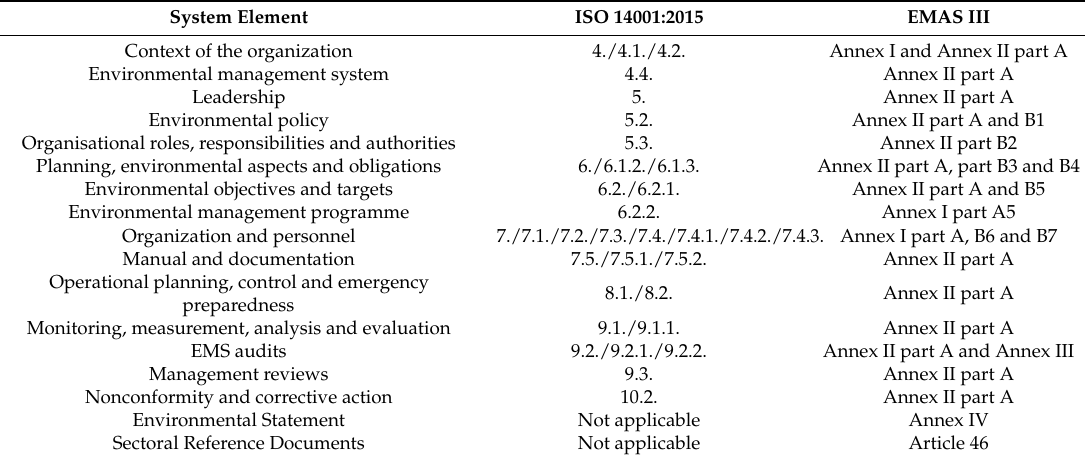
Table 2. Comparison of the ISO 14001:2015 and the EMAS III